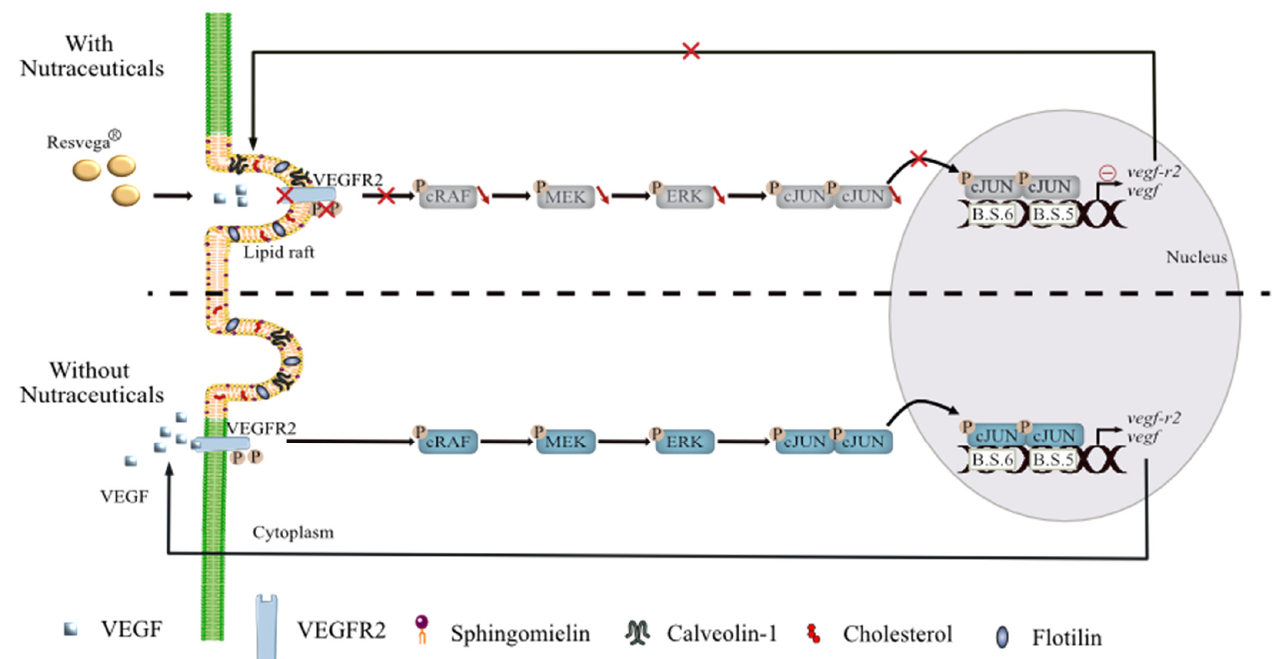
Figure 7. Suggested model to counteract VEGF-A secretion in retinal cells with AMD phenotype by nutraceuticals. Contrary to the physiopathological mechanism observed in retinal cells mimicking AMD, nutraceutical with resveratrol/ ω 3 fatty acids combination promotes (1) VEGF-R2 relocalization into lipid rafts and its binding with Cav-1, a constitutive protein of lipid rafts. This VEGF-R2-Cav-1 association, which acts as a negative regulator of the VEGF-A signaling cascade, prevents (2) the activation of MAP kinase pathway and subsequently decreases (3) phosphorylation of transcriptional nuclear factors such as c-Jun. Reduction of phospho-c-Jun level is associated with a (4) disruption of c-Jun into the nucleus. Furthermore, nutraceuticals also seemed to disrupt and antagonize AP-1 binding sites on the promoters of vegf and vegfr genes and contribute to the decrease in their mRNA and protein